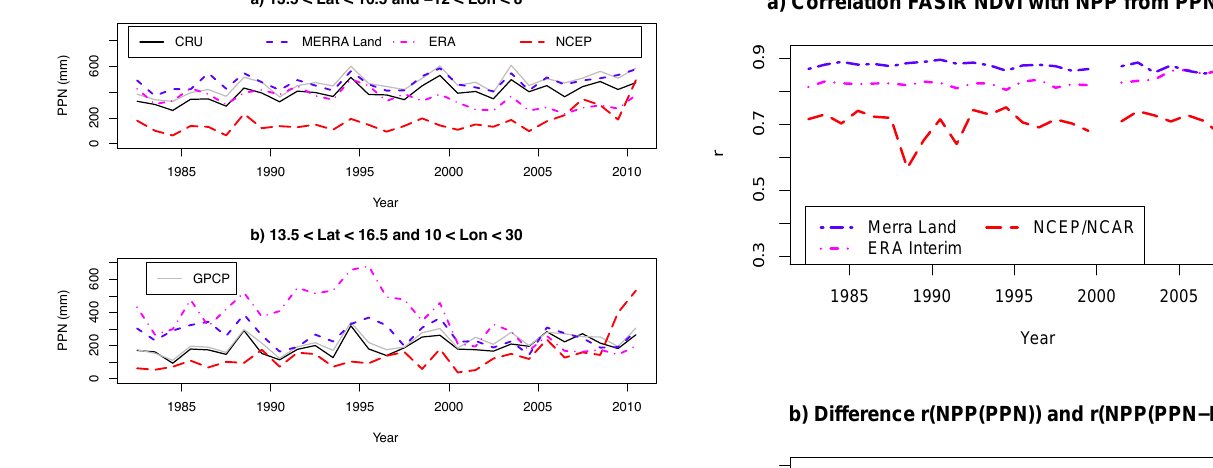
Figure 8. Precipitation time series for CRU precipitation, GPCP precipitation, MERRA Land precipitation, ERA Interim precipita- tion and NCEP/NCAR Reanalysis I precipitation. (a) For an area between 13 . 5–16 ◦ N and 12 ◦ W–8 ◦ E. (b) For an area between 13 . 5–16 ◦ N and 10–30 ◦ E. The ERA Interim precipitation tends to drift away from the observations over extended periods of time, whereas the NCEP/NCAR consistently underestimates the obser- vations. Variations in the GPCP and CRU data are closely linked. GPCP data are consistently higher, likely caused by an under-catch correction applied to the data (Huffman et al., 2009; Adam and Let- tenmaier, 2003).